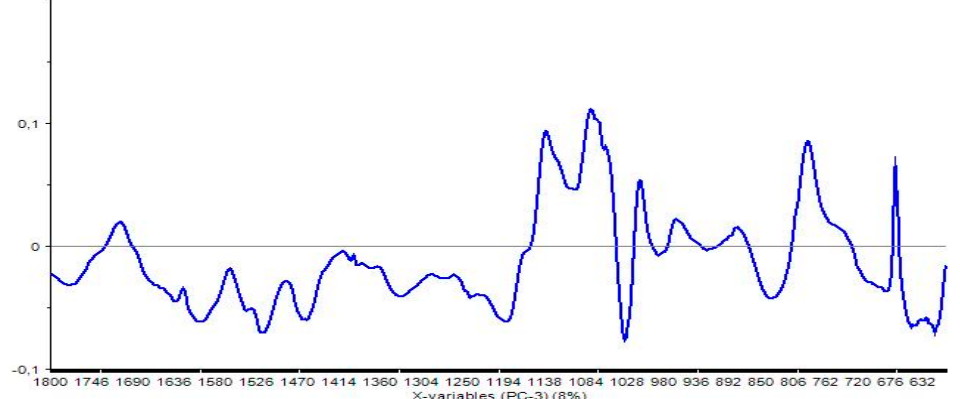
Figure 7. Loadings of the principal component 3 (PC3).